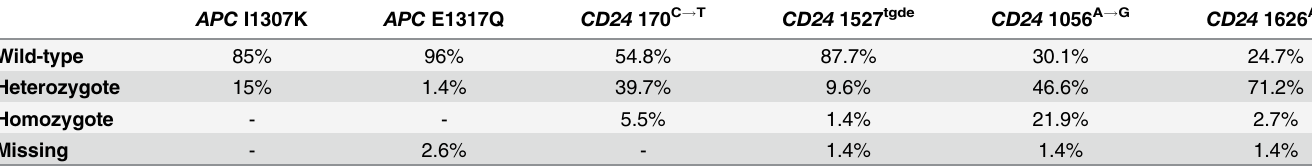
Table 2. Incidence of APC and CD24 Polymorphisms between